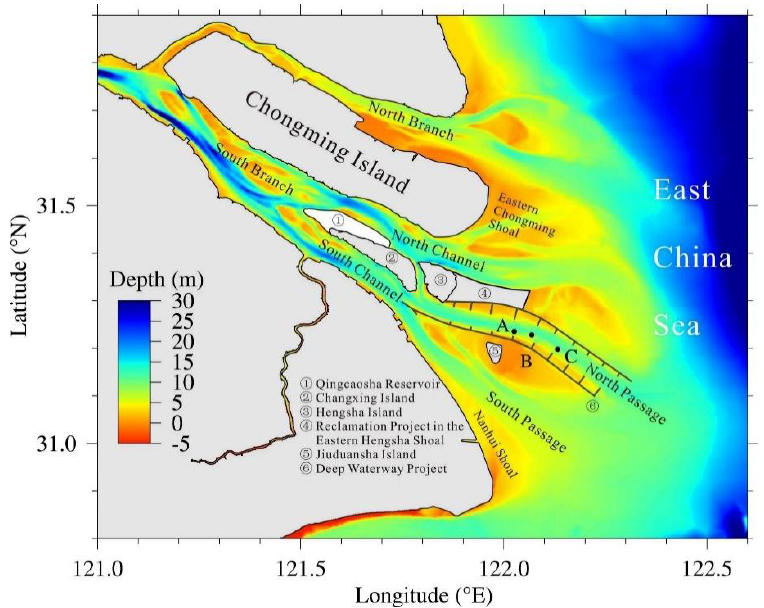
Figure 8. Topography of the Changjiang Estuary. The black dots indicate three observational stations ( A – C ).